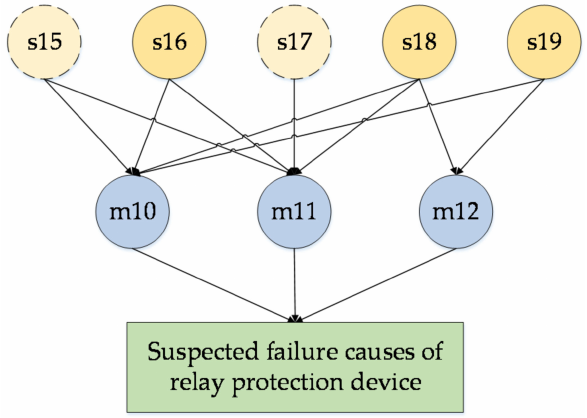
Figure 3. Bayesian network of simple fault case